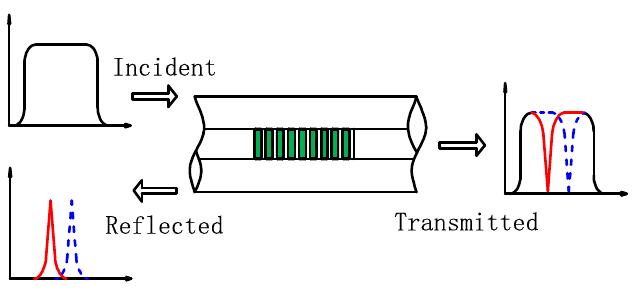
Figure 1. Principle of fiber Bragg grating (FBG).